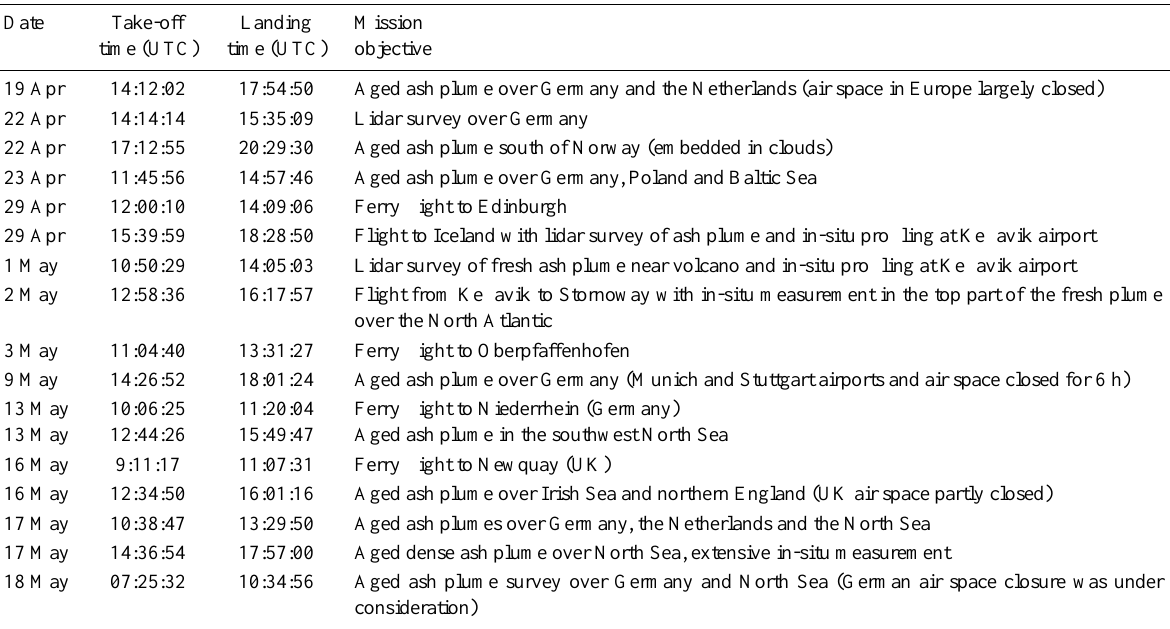
Table 2. List of Falcon flights during the DLR volcanic ash missions in April/May 2010.